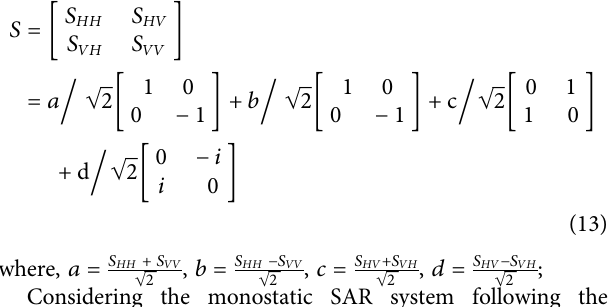
Frontiers in Earth Science |